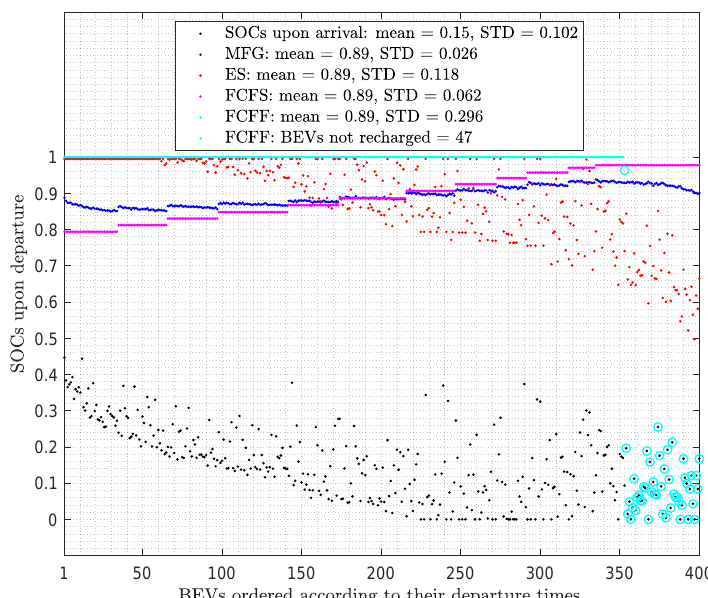
Figure 13. SOC levels at time of departure for a fluctuating population of 400 BEVs in the sunny day.